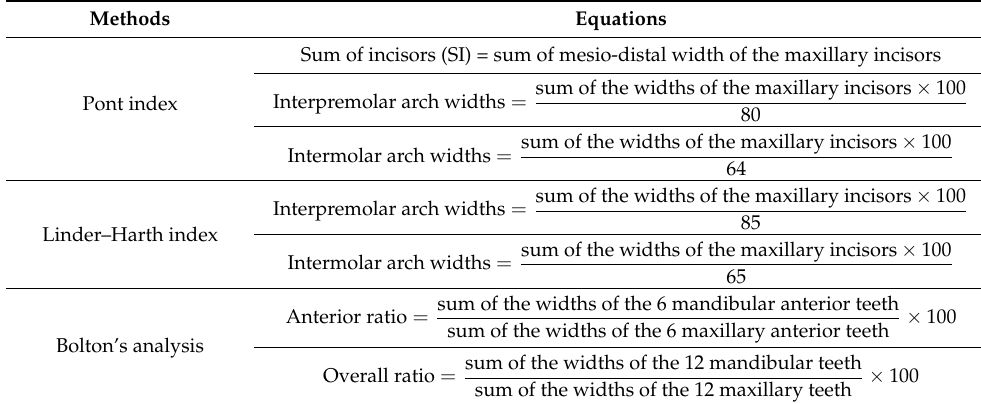
Table 1. The formulas used to calculate the development of the arches.